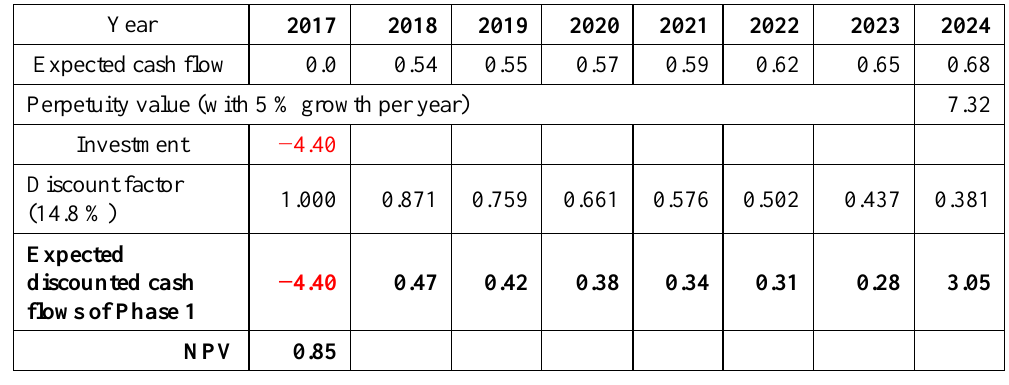
Table 4. Net Present Value of Phase 1 (millions of EUR)